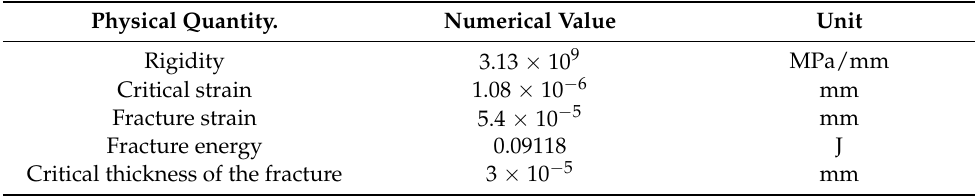
Table 2. Cohesive data of basalt